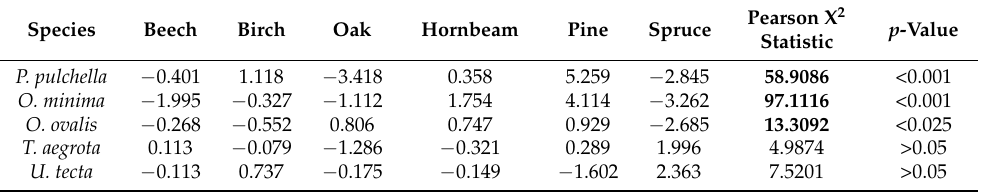
Table 2. Habitat preferences of five Uropodina species for certain tree species (statistically significant preferences in